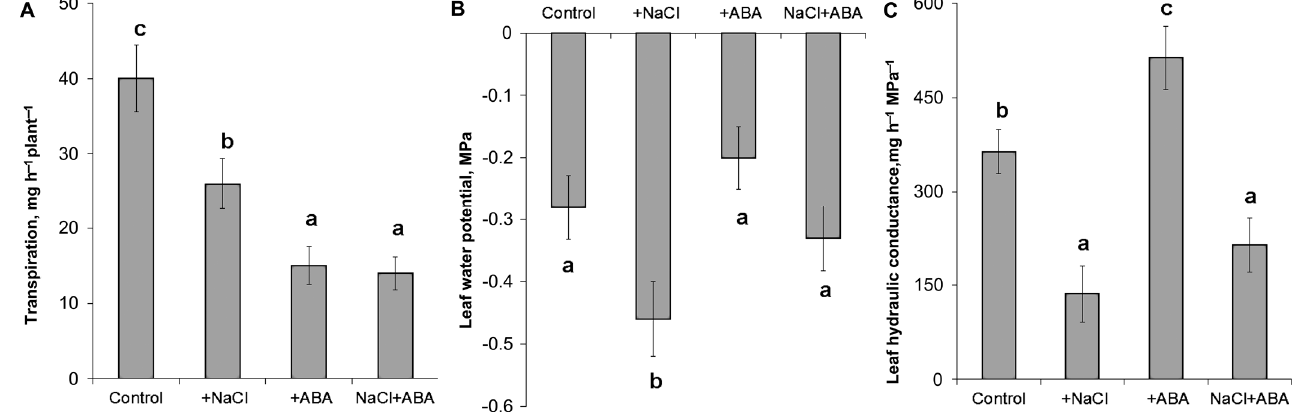
Figure 1. Effects of salinity and ABA treatment on transpiration ( A ), leaf water potential ( B ), and hydraulic conductance ( C ) of detached barley plant leaves. Statistically different values (n = 10) are labeled with different letters (Duncan test, p < 0.05).